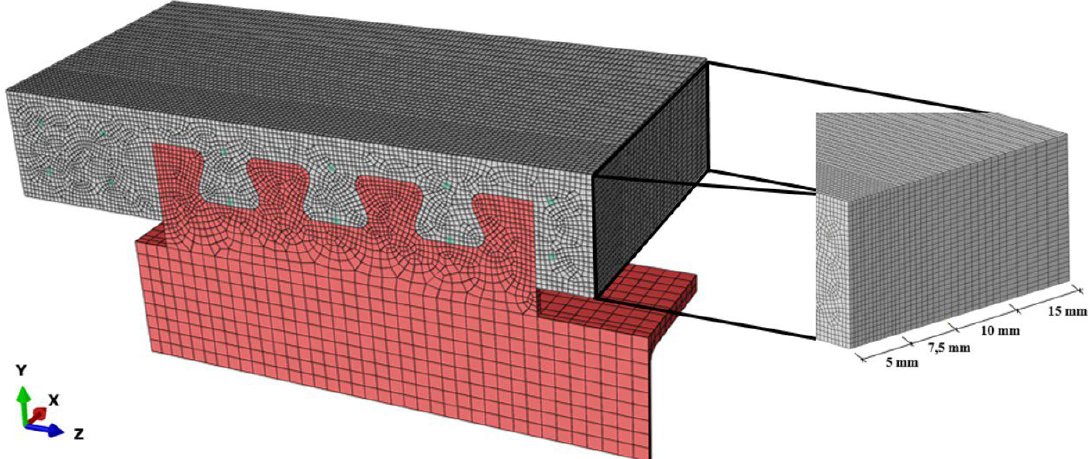
Figure 9. Finite element